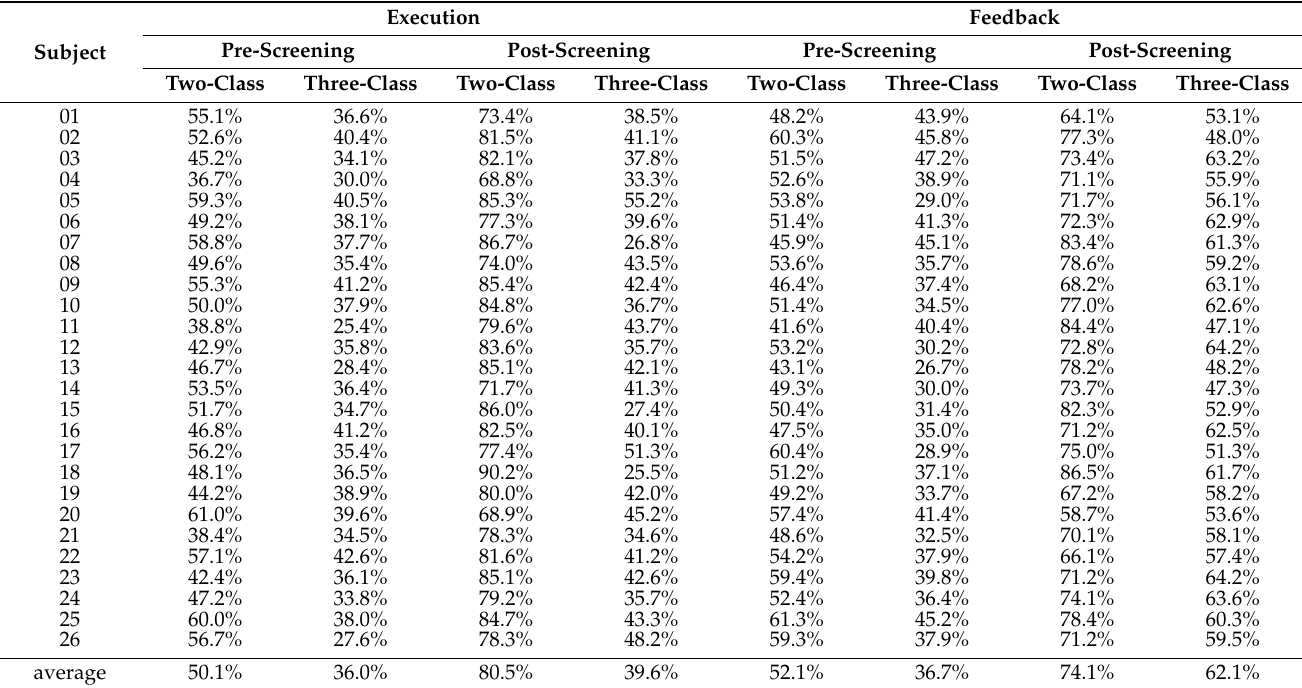
Table 3. Classification accuracy of execution and feedback of all